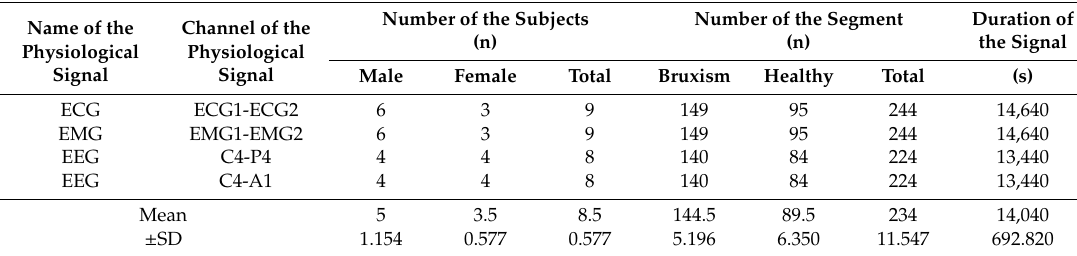
Table 1. Dataset of the present work.